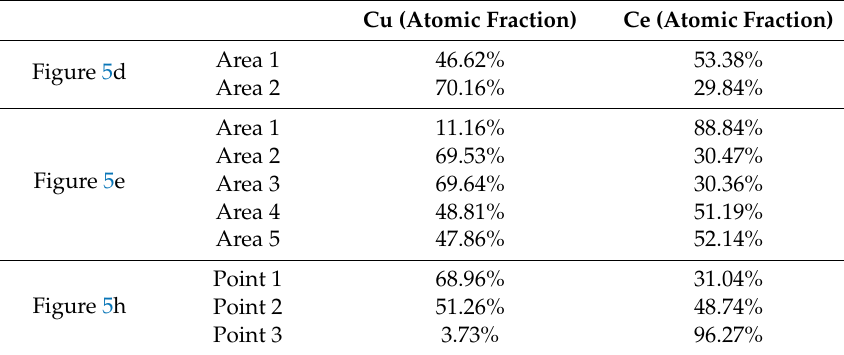
Table 3. The EDS data of directionally solidified CuCe